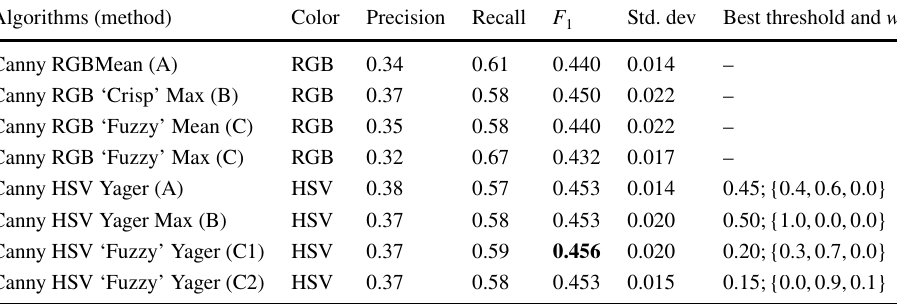
Table 4 Canny evaluated measures for HSV and RGB algorithms (average of 10 cross-validation sets)—average human